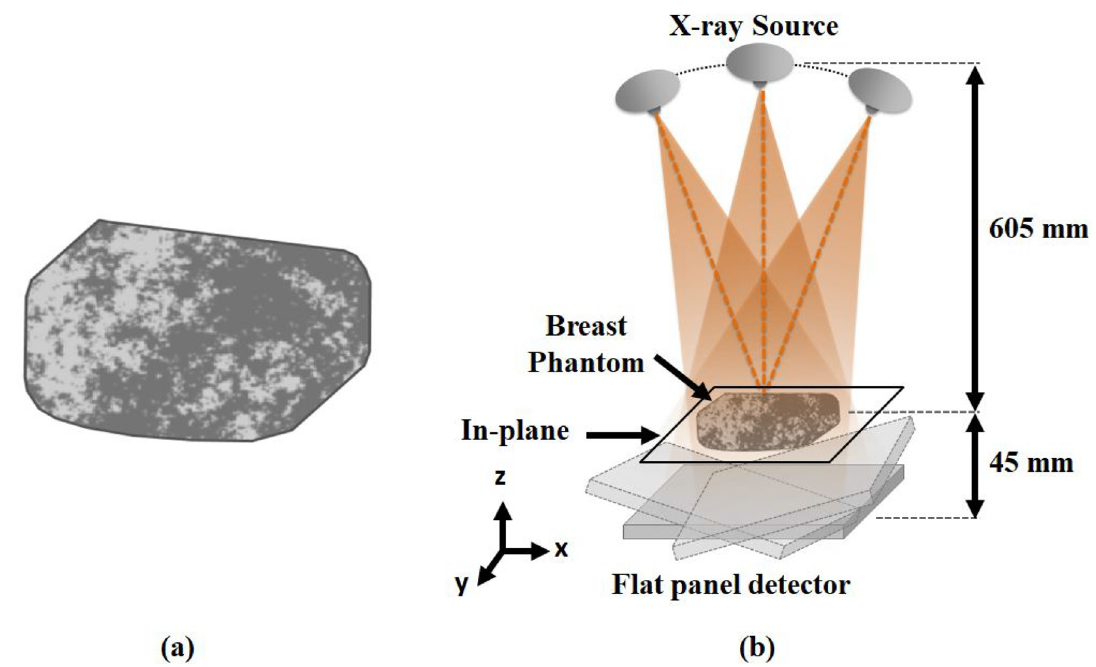
Fig 1. Breast phantom and breast tomosynthesis system geometry. (a) A simulated breast phantom with 30% VGF. The gray and black regions indicate fibro glandular and adipose tissues, respectively. The simulated breast phantoms are displayed in [0 0.1] mm − 1 . (b) The system geometry of a digital breast tomosynthesis system with a step-and-shoot mode. The X-ray source and flat-panel detector rotate simultaneously along the arc path. The projection data of simulated breast phantom are acquired within a limited data acquisition